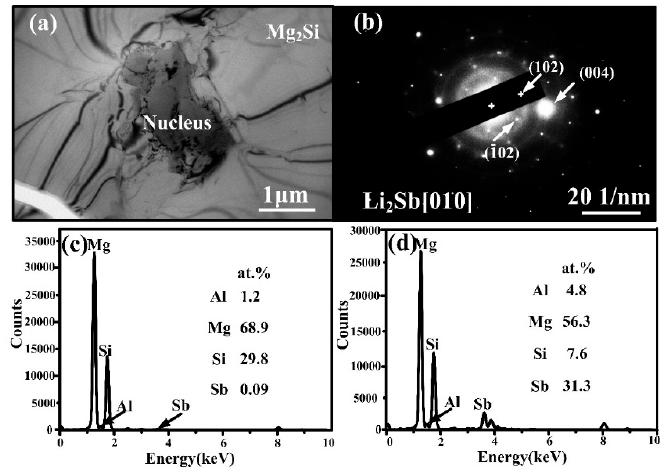
Figure 5. ( a ) TEM micrograph of the modified Mg 2 Si crystal with a nucleus; ( b ) selected-area diffraction (SAD) pattern of the nucleus in (a); ( c ) EDS for the modified Mg 2 Si crystal; and ( d ) EDS for the nucleus in (a), respectively.